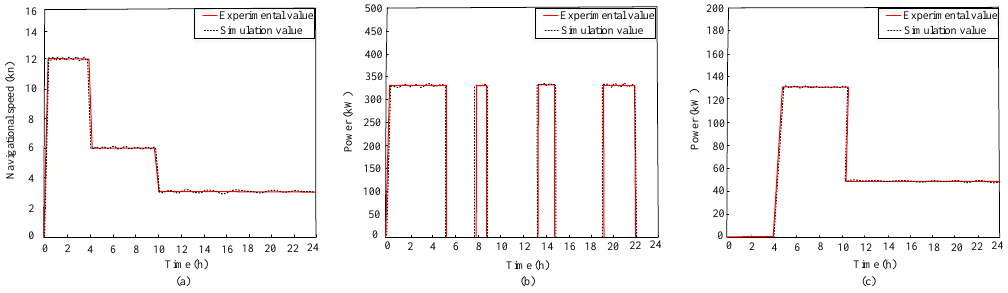
Figure 3. ( a ) Speed comparison. ( b ) Motor output power. ( c ) Output power of diesel engine.